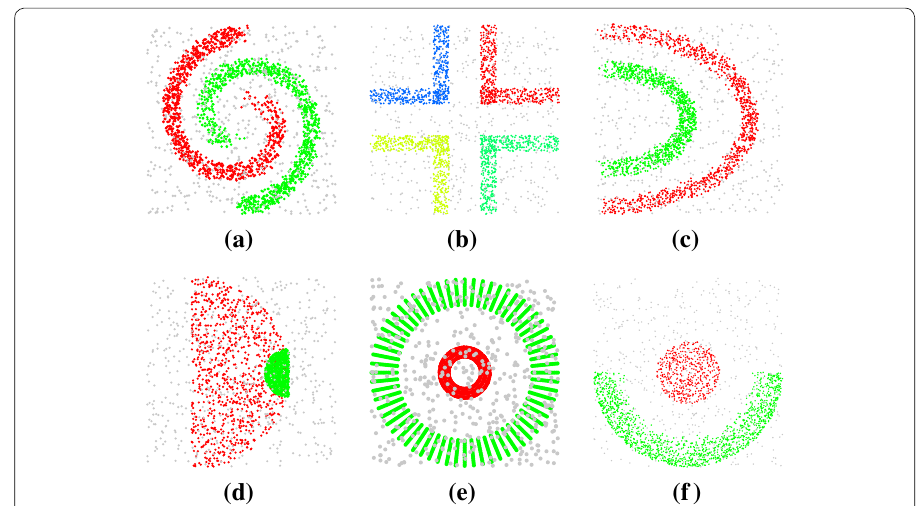
Fig. 5 Synthetic datasets for clustering. Clusters are separated by different colors and noise data is shown by moon